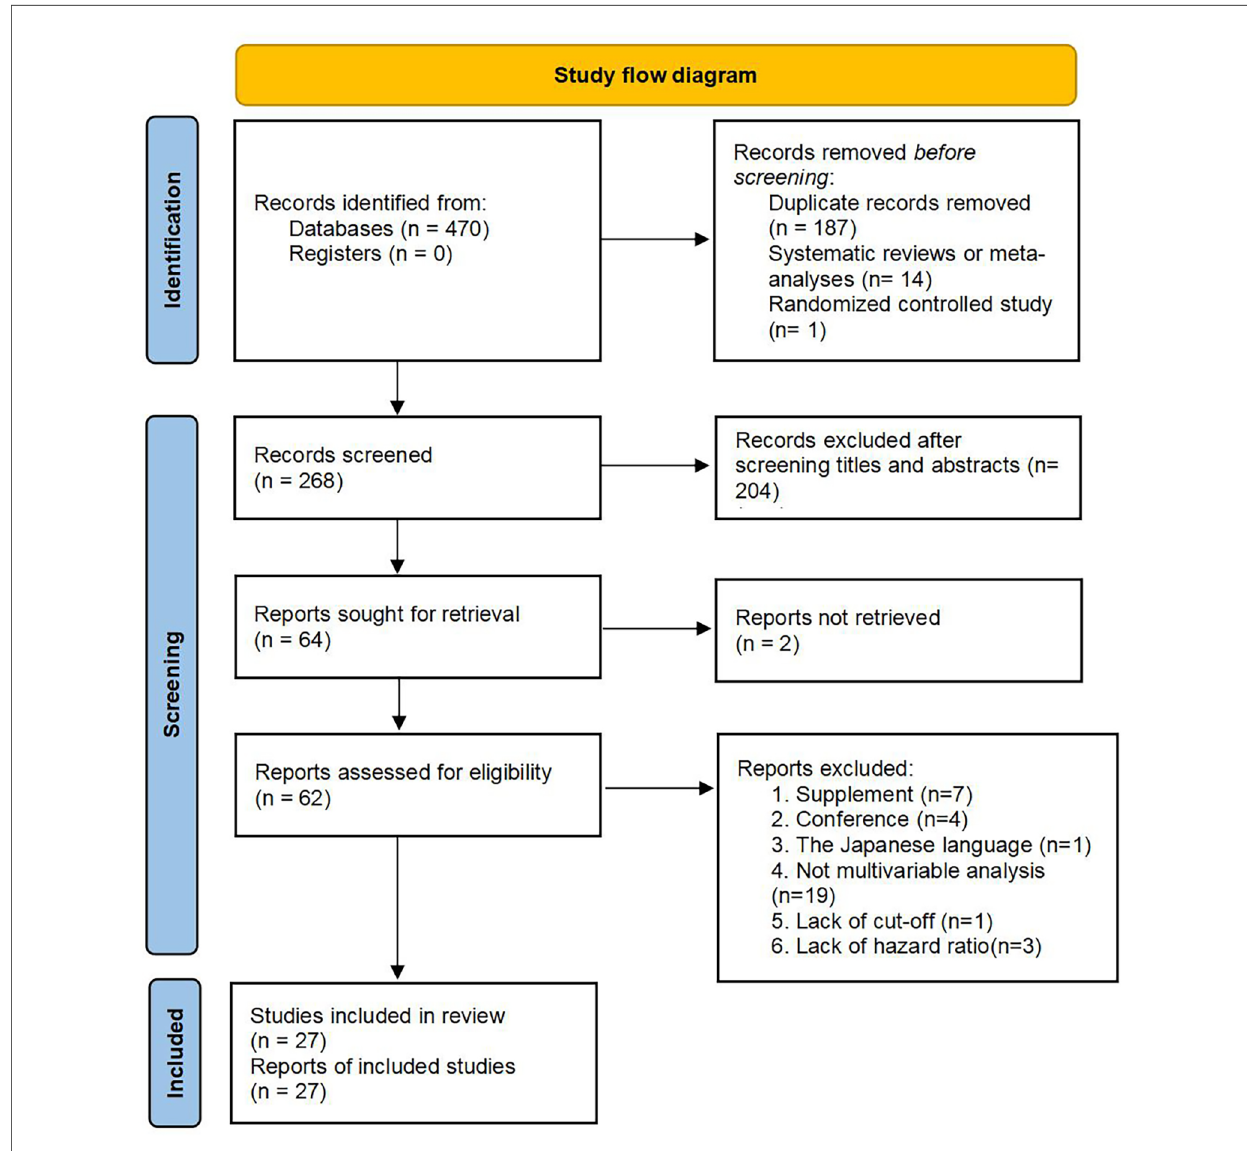
FIGURE 1 Flow diagram for study selection. From: Page MJ, McKenzie JE, Bossuyt PM, Boutron I, Hoffmann TC, Mulrow CD, et al. The PRISMA 2020 statement: an updated guideline for reporting systematic reviews. BMJ 2021;372:n71. doi: